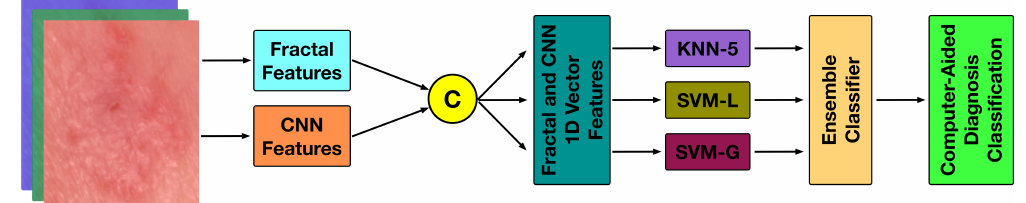
Figure 7. Block diagram of the proposed methodology. The C within a yellow circle represents the concatenation operation.